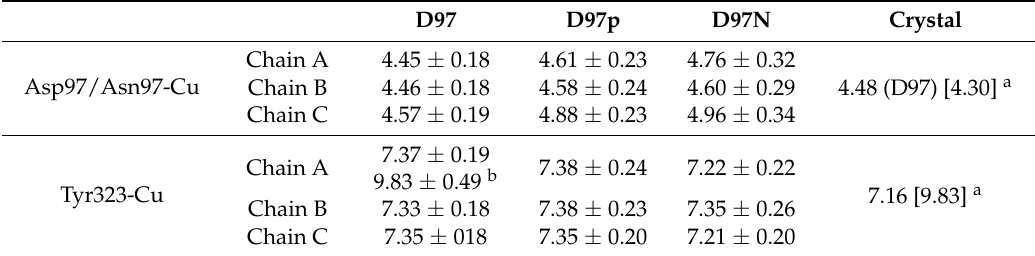
Table 1. Average distances between the T2Cu ion and the centres of mass of Asp/Asn97 and Tyr323 sidechains during 75 ns of unconstrained MD simulation. The equivalent crystal structure values are provided for comparison. Distances are in